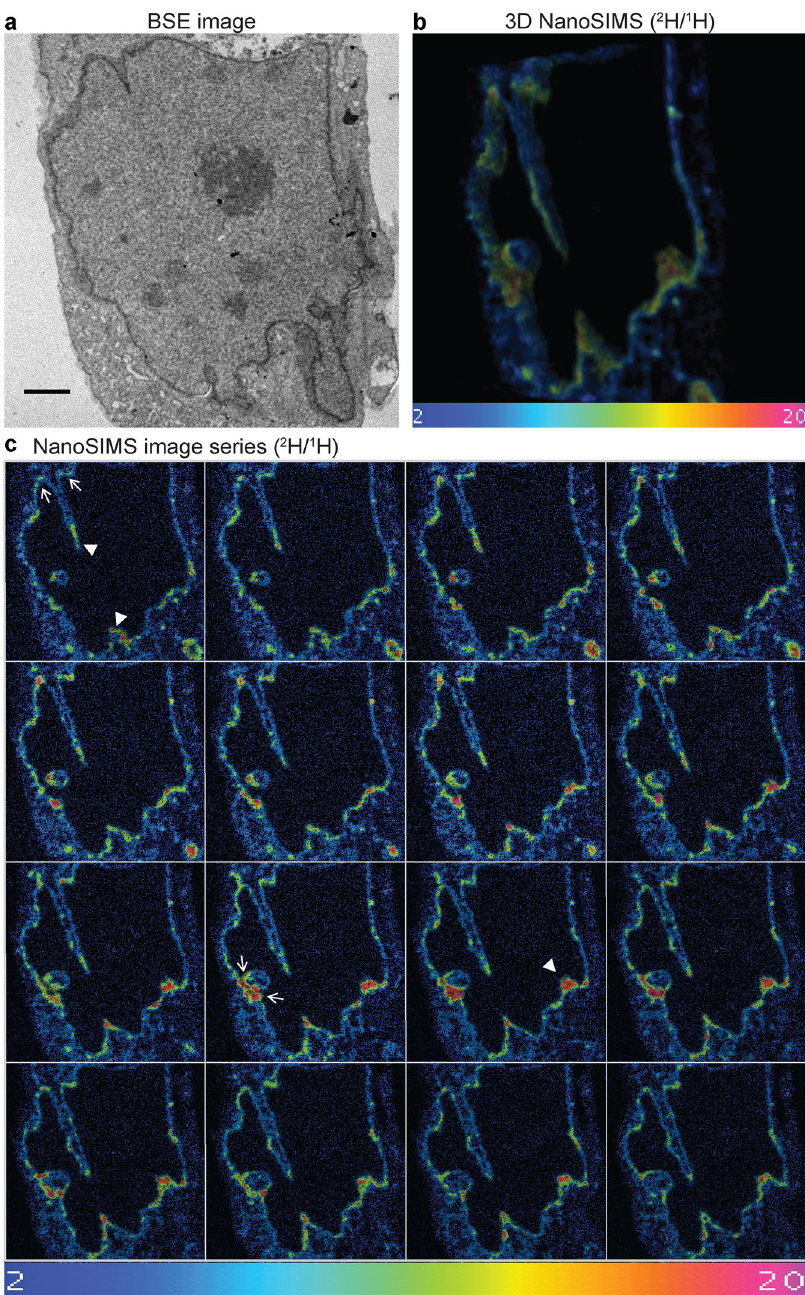
Figure 6. 3D NanoSIMS of nascent phospholipid distribution during NR formation. ( a ) Representative backscattered electron (BSE) image of a saquinavir-treated mouse preadipocyte pulsed labelled with deuterated choline; scale bar 2 µ m. ( b ) 3D reconstruction of NanoSIMS analysis of subsequent layers of the specimen shown in ( a ). ( c ) Panel of NanoSIMS images used for the 3D reconstruction shown in ( b ); examples of tip and base region of NR tubules are indicated by arrowheads and arrows, correspondingly; a single image corresponds to ~10 nm specimen thickness. Colour scale of NanoSIMS images 2–20 equals 0.02–0.2% of 2 H/ 1 H ratio. See corresponding Supplementary Movies 2 and